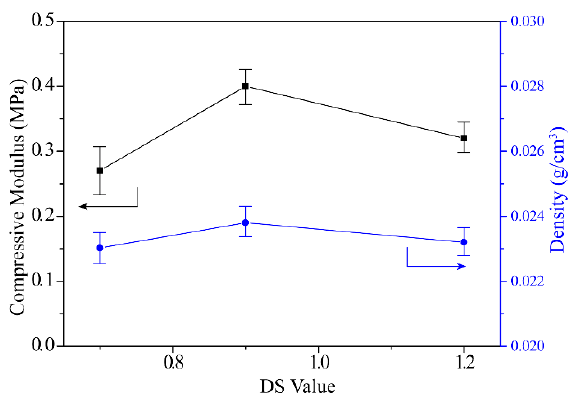
Figure 3. Compressive modulus and density of CMC cellulose aerogels with DS = 0.7, 0.9 and 1.2.